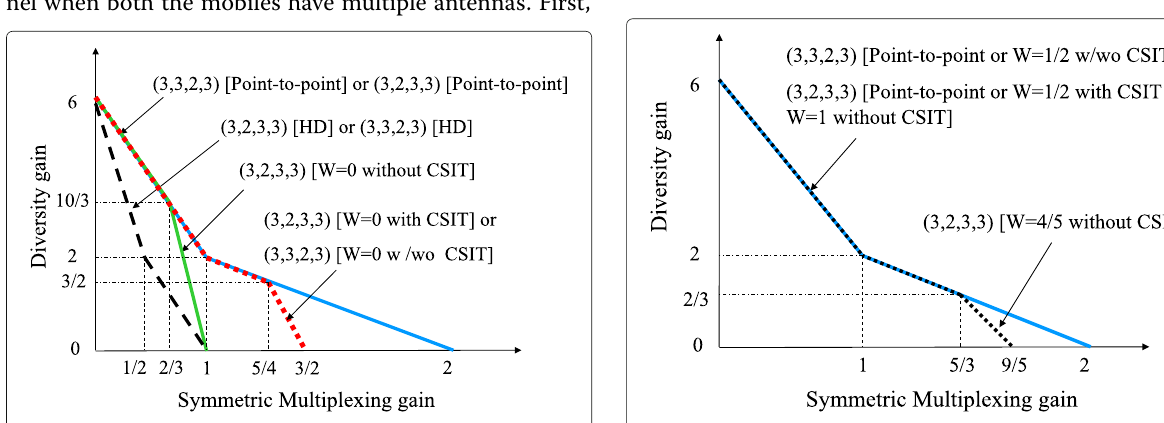
Fig. 15 The symmetric DMT with side channel for α dl = α ul = α I = = α S